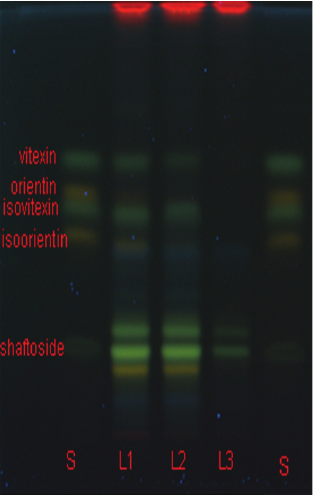
Figure 2: TLC profile of standards and extracts of C. nutans leaves from different location. S: standard mixtures of shaftoside ( 𝑅 𝑓 = = 0.48 ), isovitexin ( 𝑅 = 0.56 ), orientin 0.23 ), isoorientin ( 𝑅 𝑓 𝑓 ( 𝑅 𝑓 = 0.60 ), and vitexin ( 𝑅 𝑓 = 0.66 ). C. nutans samples L1: Taiping, Perak, L2: Kota Tinggi, Johor, and L3: Sendayan, Negeri Sembilan.